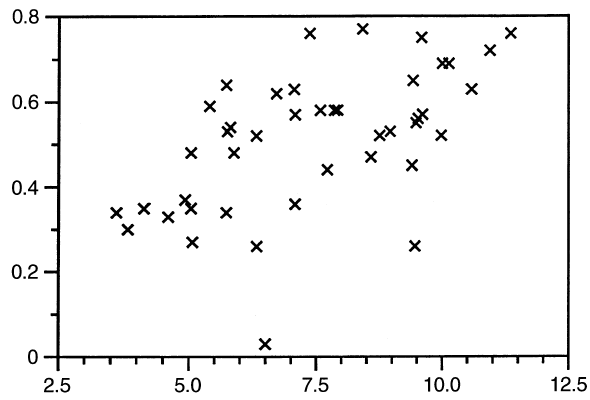
Fig. 7. Total correlation (see text) between the drifters and model velocities in relation to the average velocity norm of the drifters (cm/s)